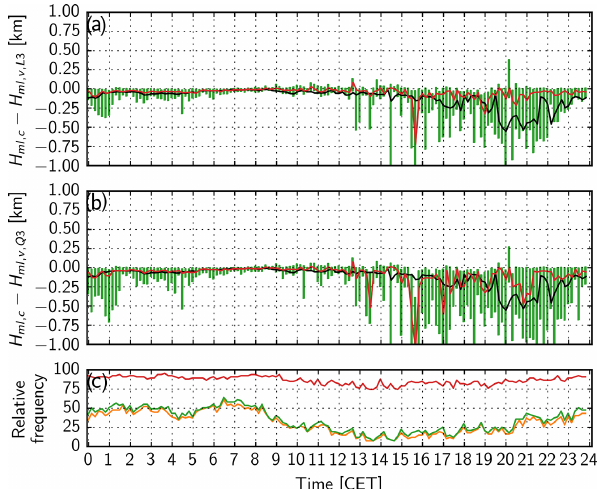
Figure 4. (a) Difference (cid:49)H of the retrieved MLH from COBOLT and BL-VIEW L3 during the BAERLIN2014 campaign: vertical lines indicate the interval from the 25th to the 75th percentile. The red line is the median of the distribution. For comparison the cor- responding median from the L1 criterion is shown (black line). (b) Same as top panel but (cid:49)H of the retrieved MLH from COBOLT and BL-VIEW Q3. (c) Relative frequency of successful H ml , v - retrievals (L3 in orange, Q3 in green, L1 in red) in percent in re- lation to the COBOLT